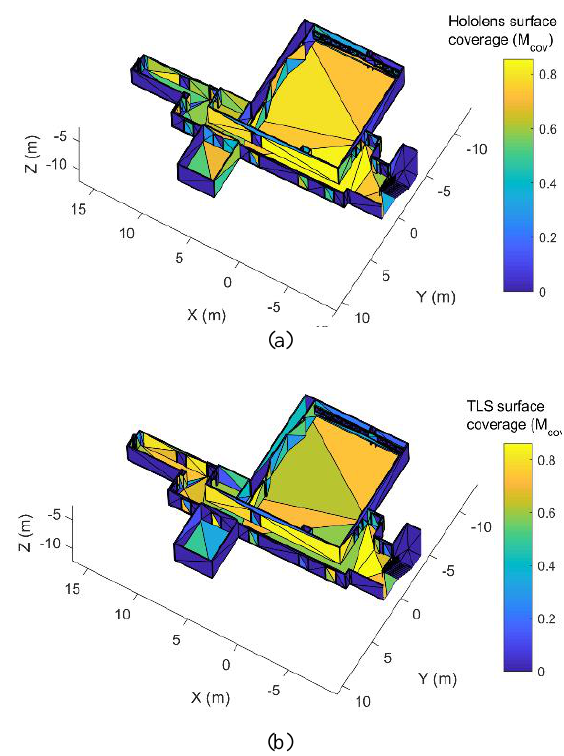
Figure 12. Coverage of the surfaces of the 3D model by the Hololens mesh (a) and the laser scanner point cloud (b).